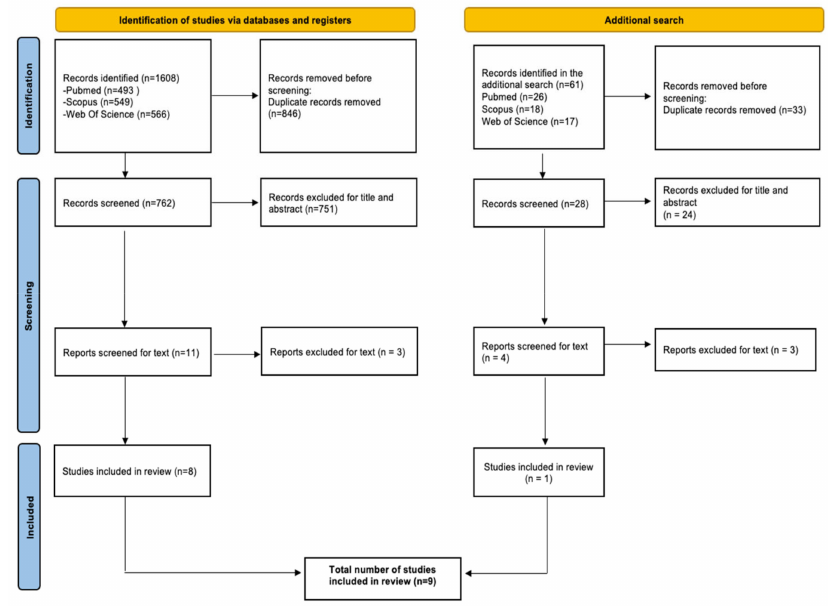
Figure 1. PRISMA checklist for the identification of